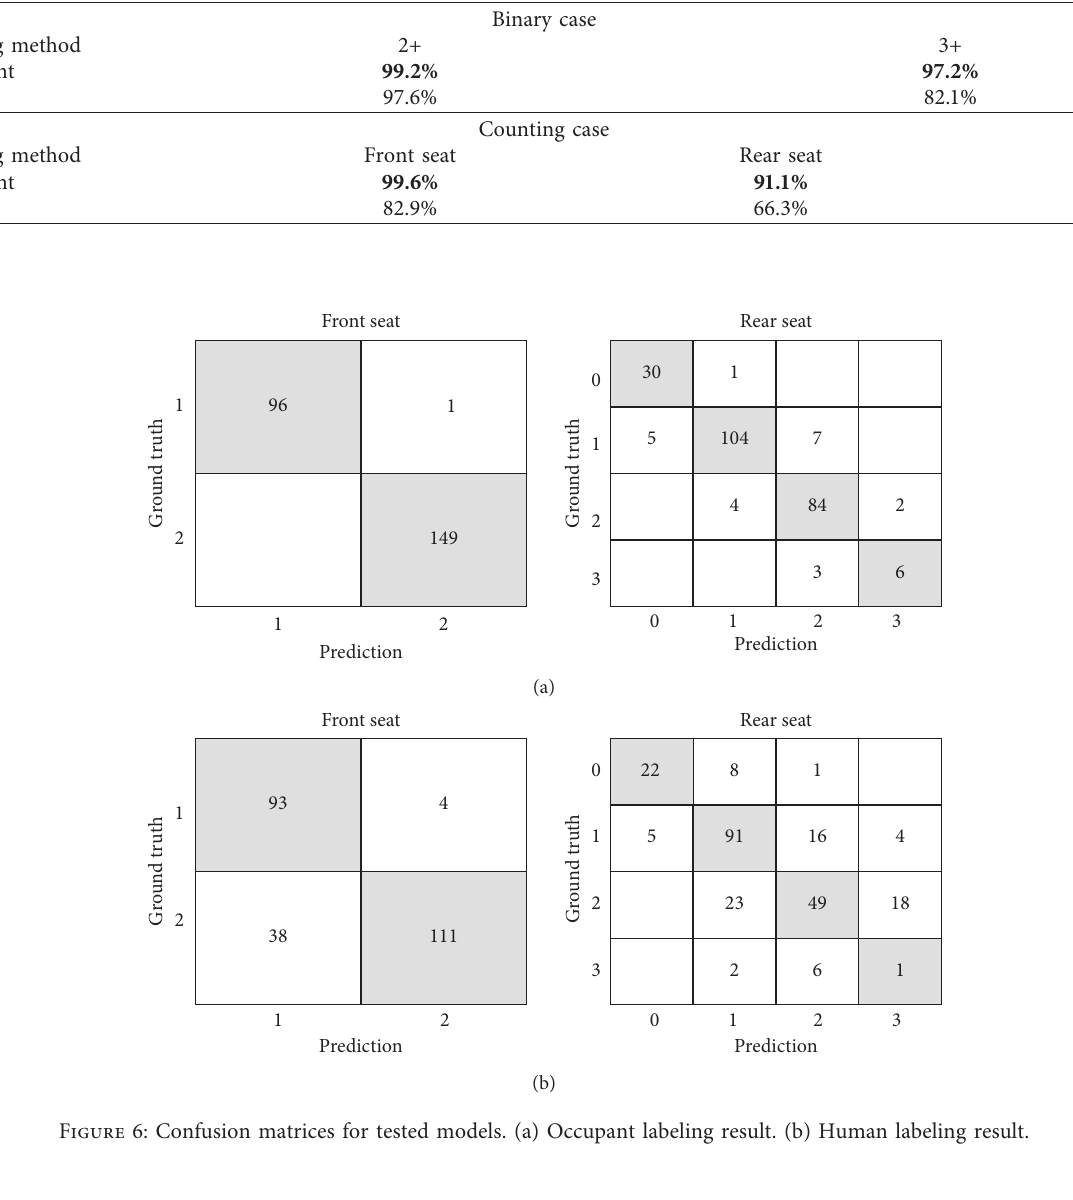
Figure 5: Examples of vehicle occupancy detection results for both models. (a) Occupant labeling result. (b) Human labeling result. Table 1: Detection accuracy for both models using two images.